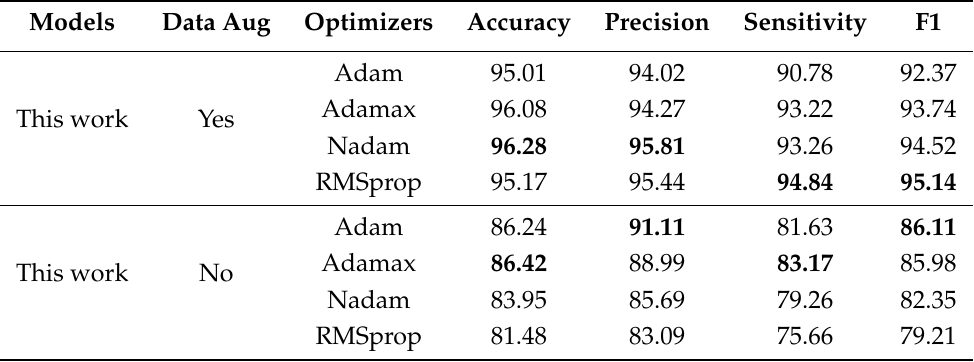
Table 4. Model performance